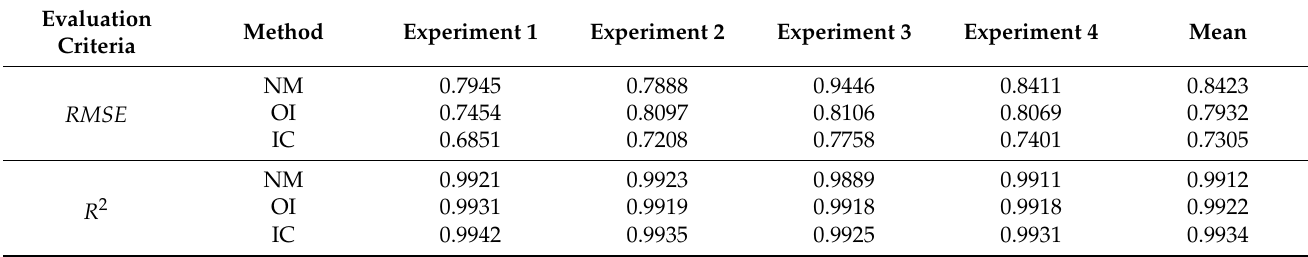
Table 2. RMSE and R 2